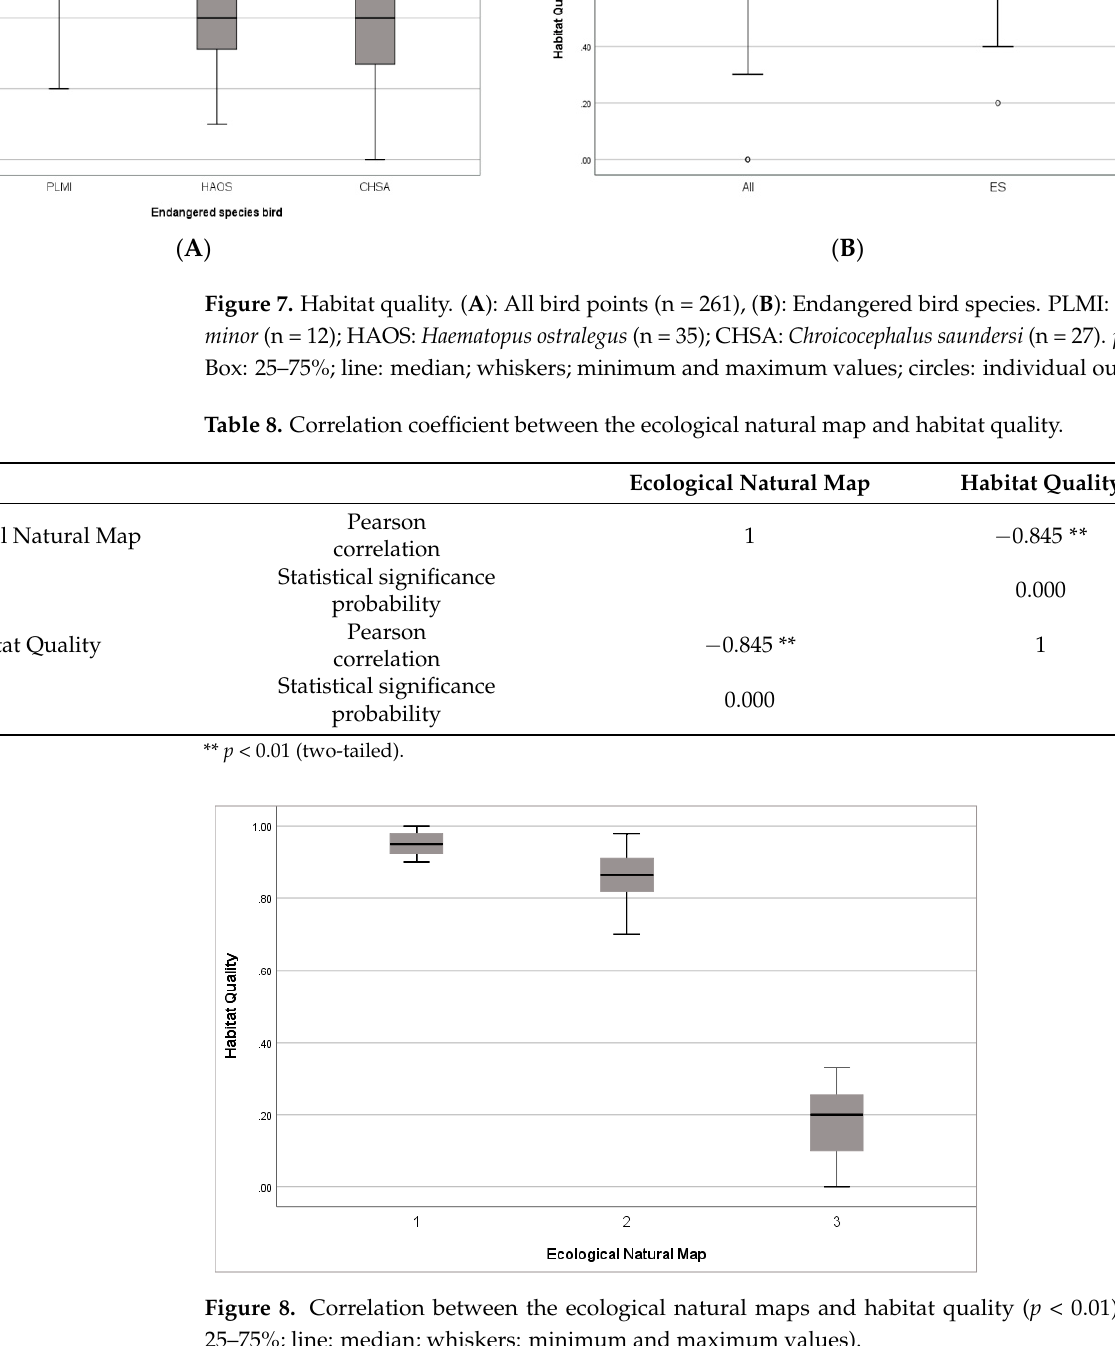
Figure 7. Habitat quality. ( A ): All bird points (n = 261), ( B ): Endangered bird species. PLMI: Platalea minor (n = 12); HAOS: Haematopus ostralegus (n = 35); CHSA: Chroicocephalus saundersi (n = 27). p < 0.05. Box: 25–75%; line: median; whiskers; minimum and maximum values; circles: individual outliers.